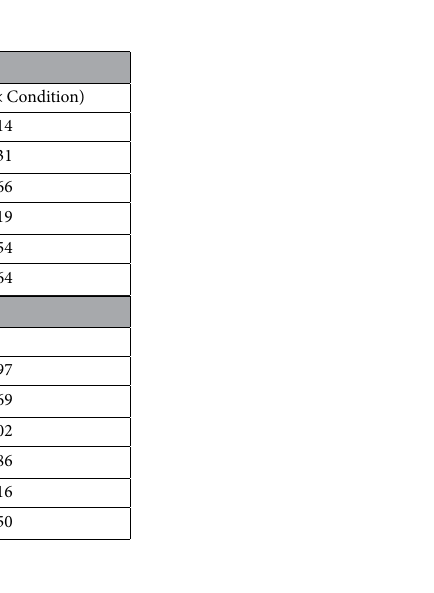
Figure 4. Differences in (cid:31) HR (left) and each MIST phase.